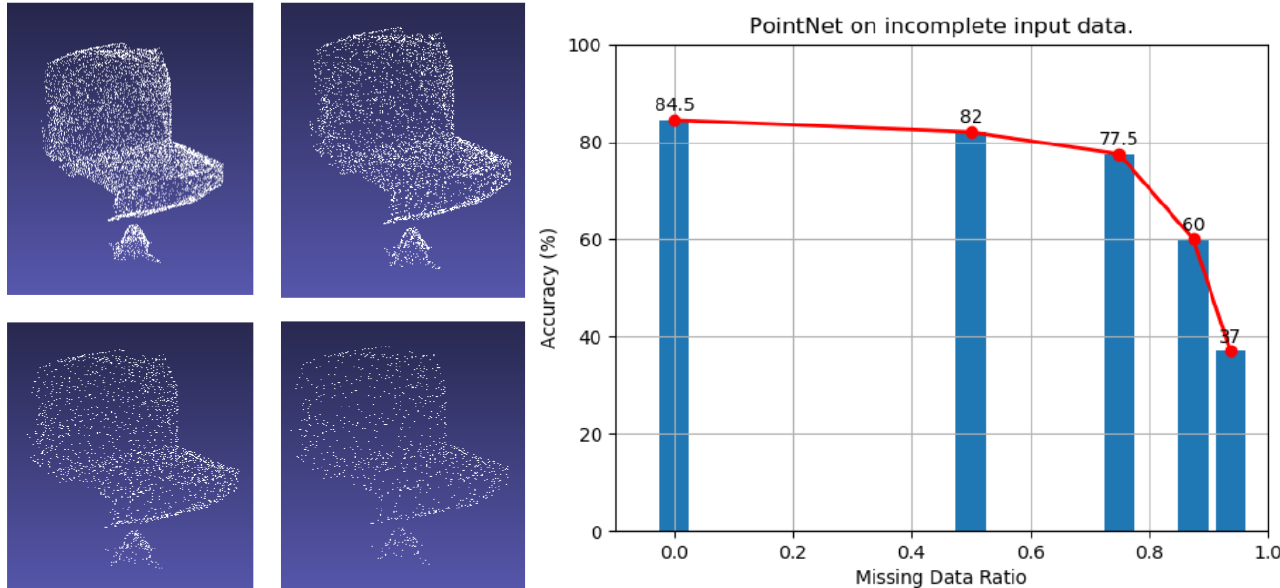
Figure 2. On the left is the default rate display of the point cloud. The line chart on the right describes the default recognition rate of the point cloud in the left scene,